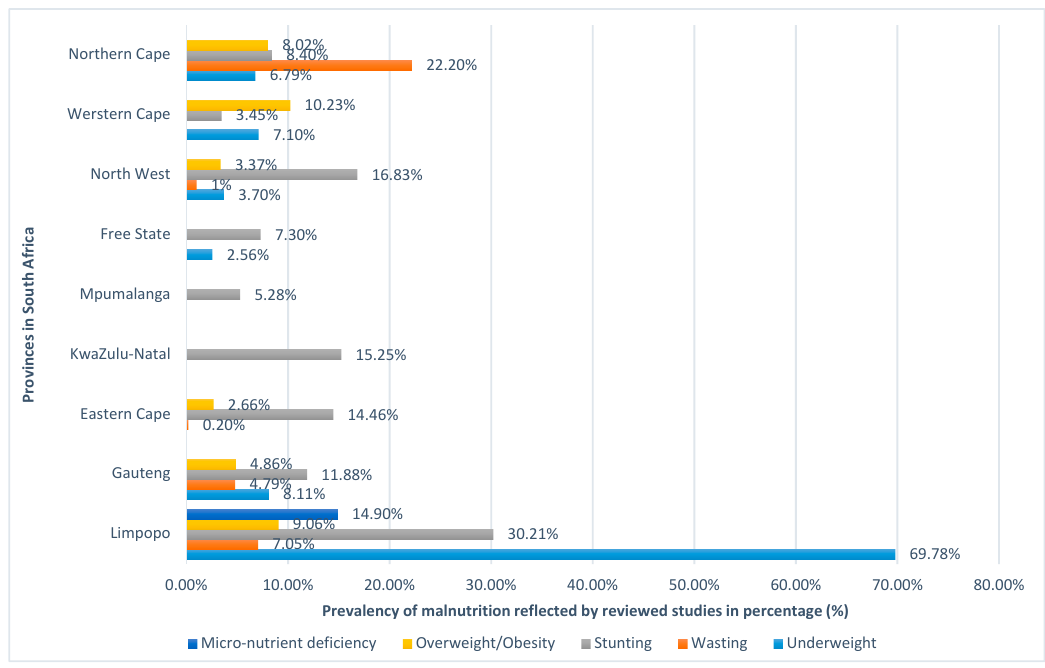
Figure 4. The prevalence of child malnutrition in South Africa as depicted by the selected studies.